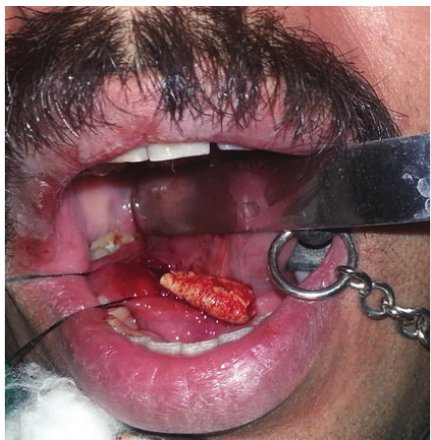
Figure 3: Sialolith evacuated.